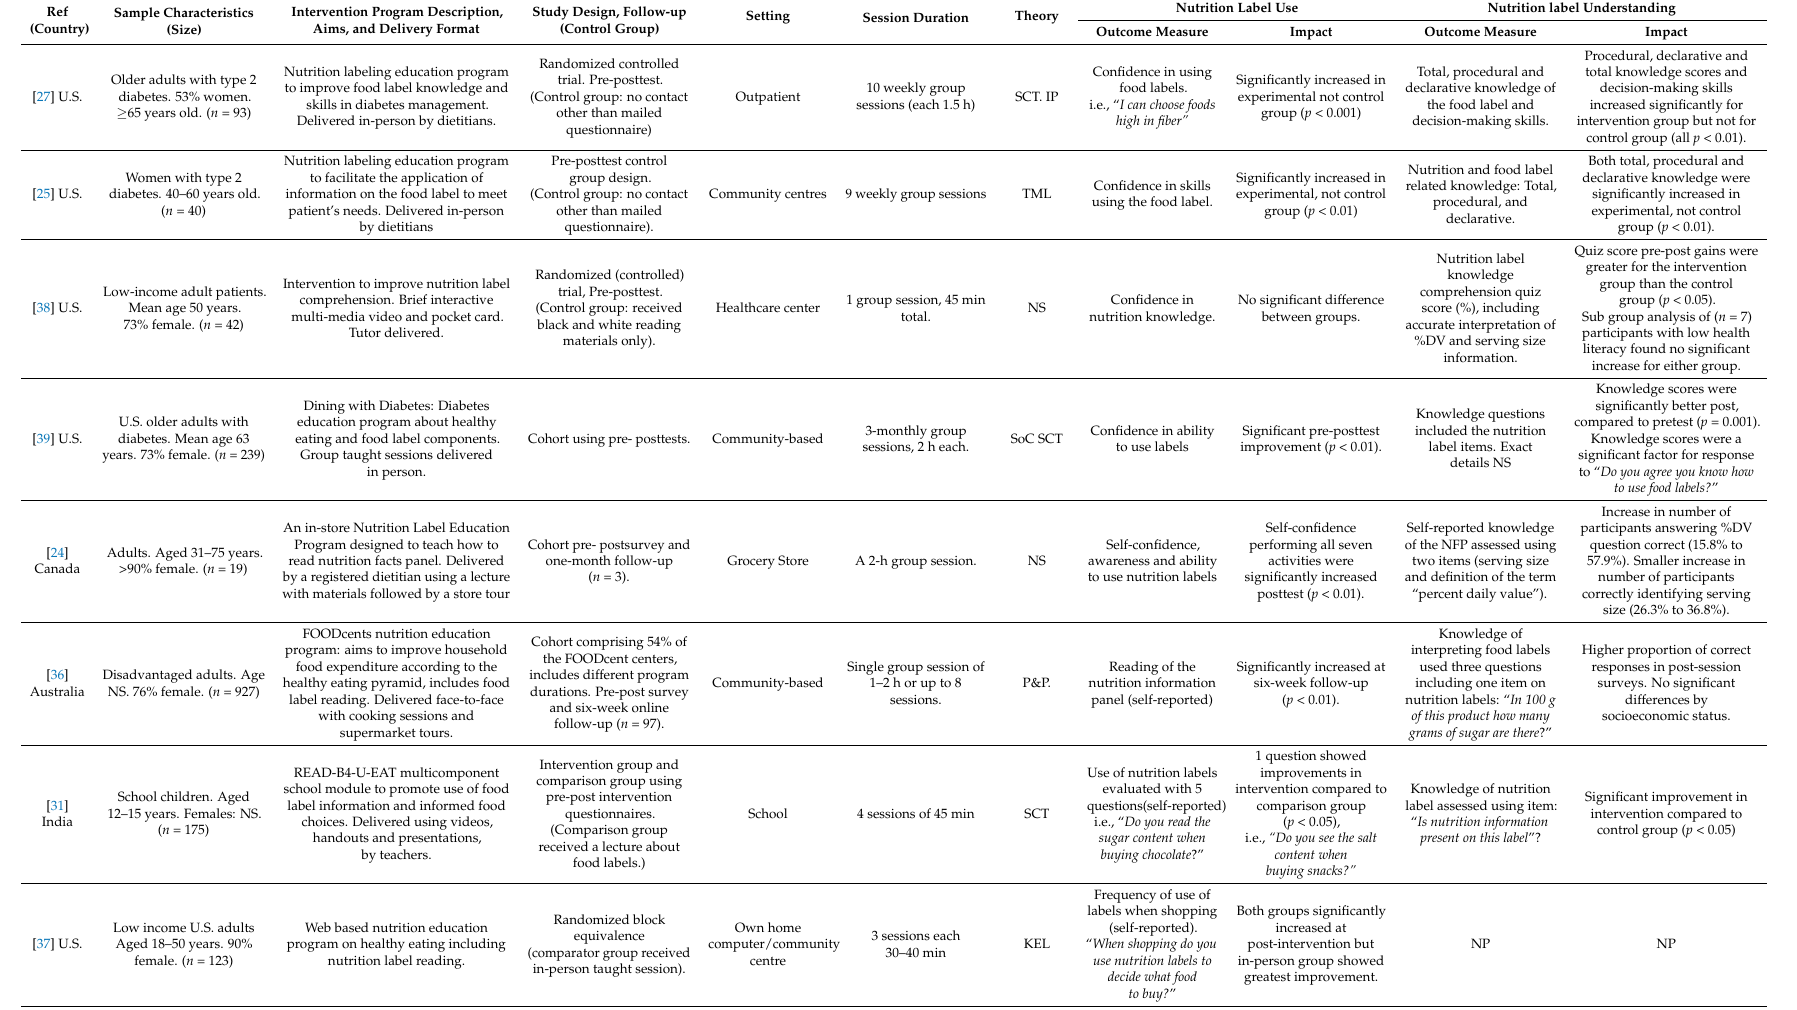
Table 1. Summary of studies reporting outcomes of “use” and “understanding” of nutrition